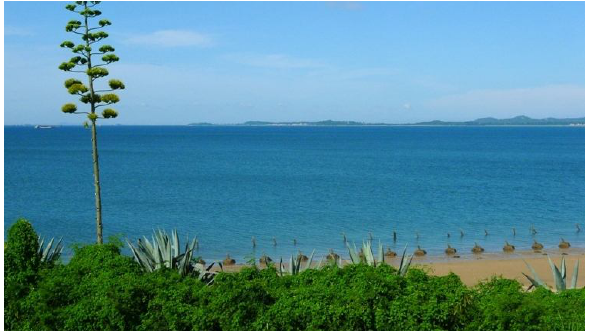
Figure 4. The Point W16 in Kinmen National Park